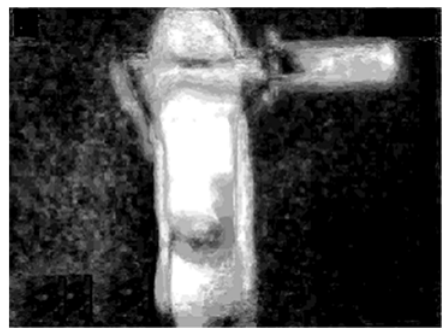
Figure 13. Binary image (0.1 < | ag1b ‐ ag2b| < 1) of difference: | ag1b ‐ ag2b| . The computed matrix K for all training thermal images of the angle grinder is presented in Figure 14.